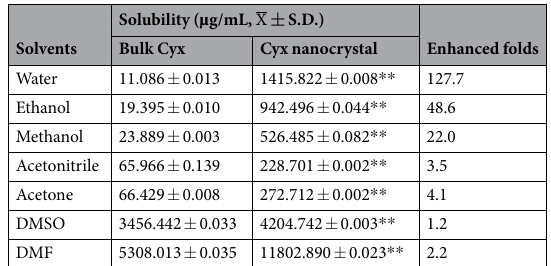
Table 2. Solubility of bulk Cyx and Cyx nanocrystal in various solvents (25 °C, standard atmospheric pressure). * Statistical significances compared with bulk Cyx are p < 0.01.